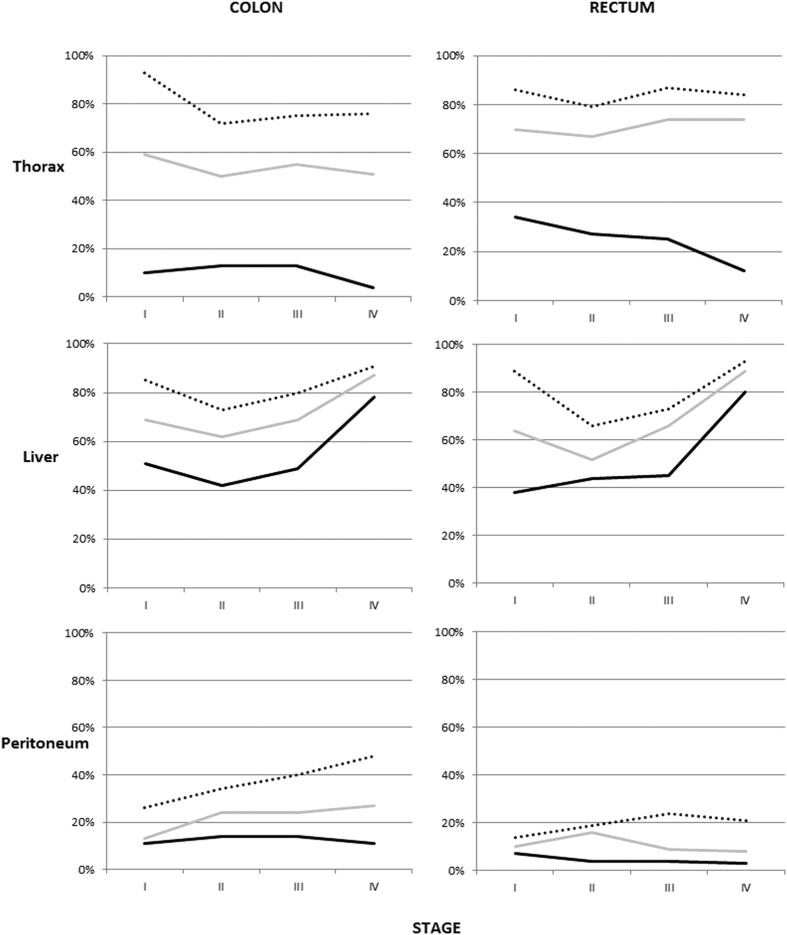
Frequency of thoracic, liver, and peritoneal metastases in patients with colon or rectal cancer, depending on how many metastases were present and the stage of patients.Black line: one metastasis, gray line: two metastases, dotted line: three or more metastases.